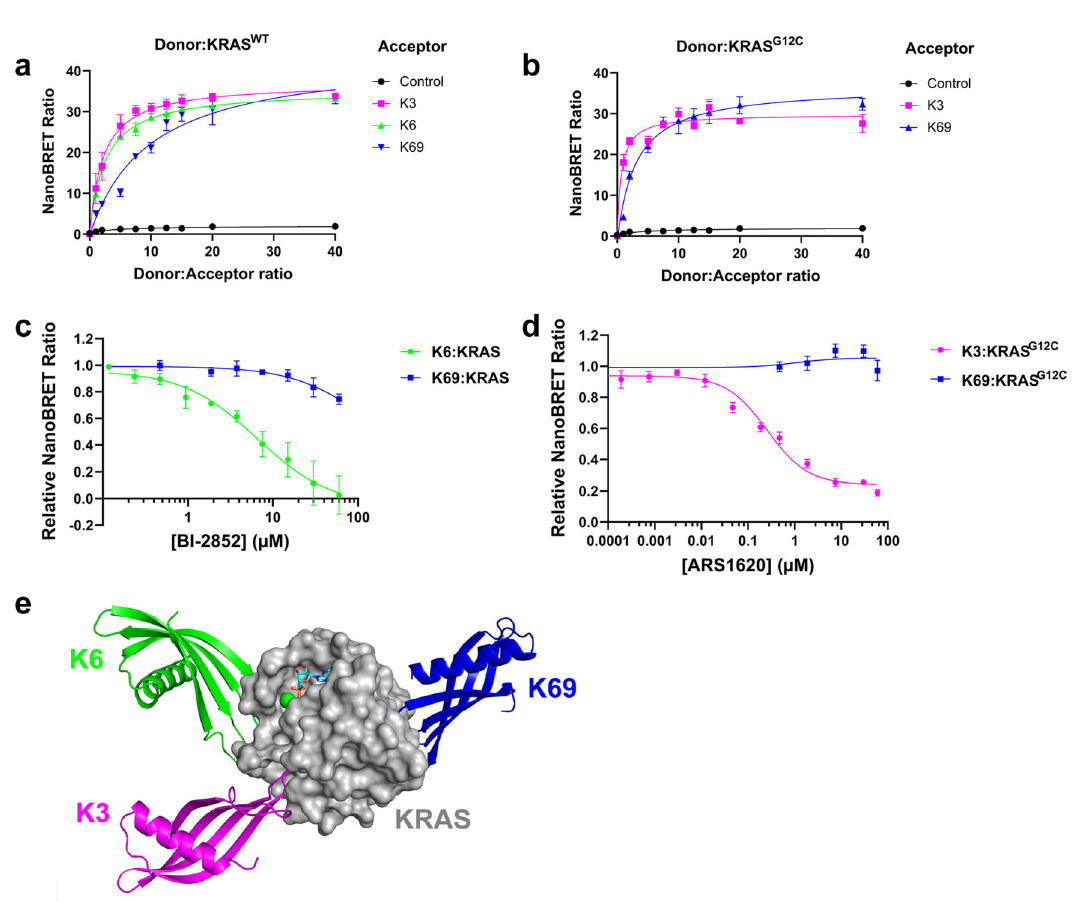
Fig. 7 Af fi mer:KRAS NanoBRET can be used to identify small molecules which bind in the SI/SII or SII/ α 3 pocket. Increased Af fi mer (acceptor) to KRAS (donor) ratio increases the NanoBRET signal as measured by NanoBRET Ratio for Af fi mers K3, K6, and K69 with KRAS WT ( a )) and Af fi mers K3 and K69 with KRAS G12C ( b )). Small molecule BI-2852 binds in the SI/SII pocket and increasing concentrations displace Af fi mer K6 reducing the NanoBRET Ratio with no impact on NanoBRET signal from Af fi mer K69 that binds between helix 4 and helix 5 ( c )). ARS-1620 covalently tethers to C12 in KRAS G12C and occupies the SII pocket, and increasing concentrations displace Af fi mer K3 reducing the NanoBRET Ratio with no impact on NanoBRET signal from Af fi mer K69 ( d )). e Af fi mer K69 (blue) binds the allosteric lobe between helices 4 and 5 on the opposite side of KRAS (gray) to Af fi mers K3 (magenta) and K6 (green). Data are mean ± SEM, fi tted to 3 parameters [agonist]/[inhibitor] vs. response model in Prism, n = 3 independent experiments for all assays. Images were generated in MacPyMOL v1.7.2.3 from PDB codes 6YXW (K3), 6YR8 (K6), and 7NY8 (K69). Control Af fi mer (Variable regions of AAAA and